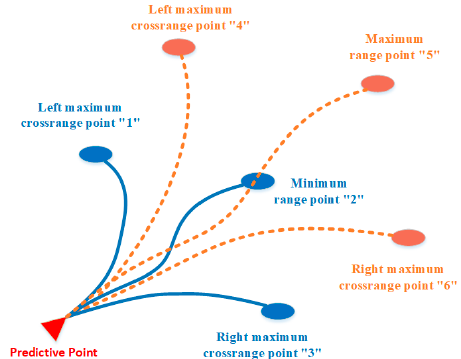
Figure 3. The six boundary points’ schematic.